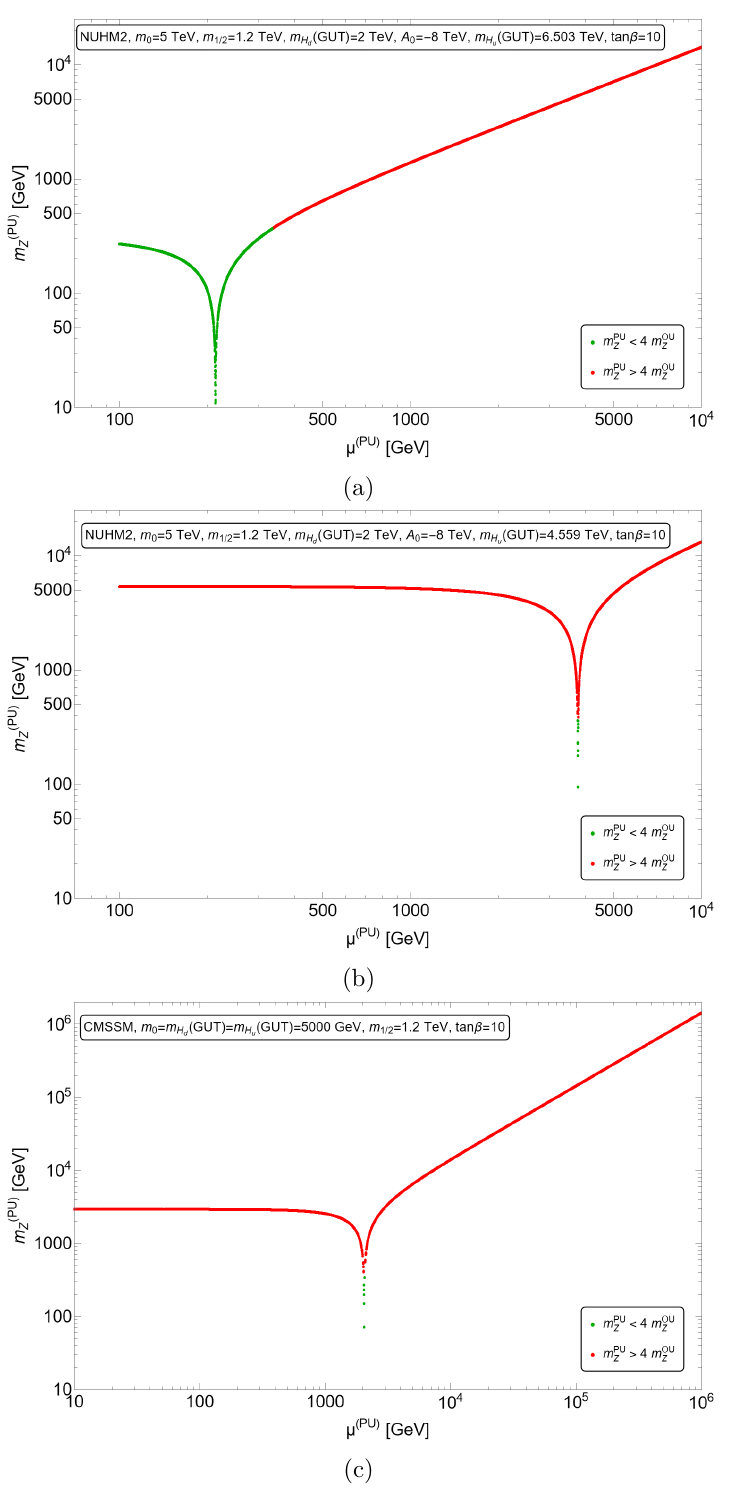
Figure 9. The value of m PU vs. µ PU The green points denote vacua with appropriate EWSB and weak with m PU < 4 m OU so that the atomic principle is satisfied. Red points have m PU weak weak